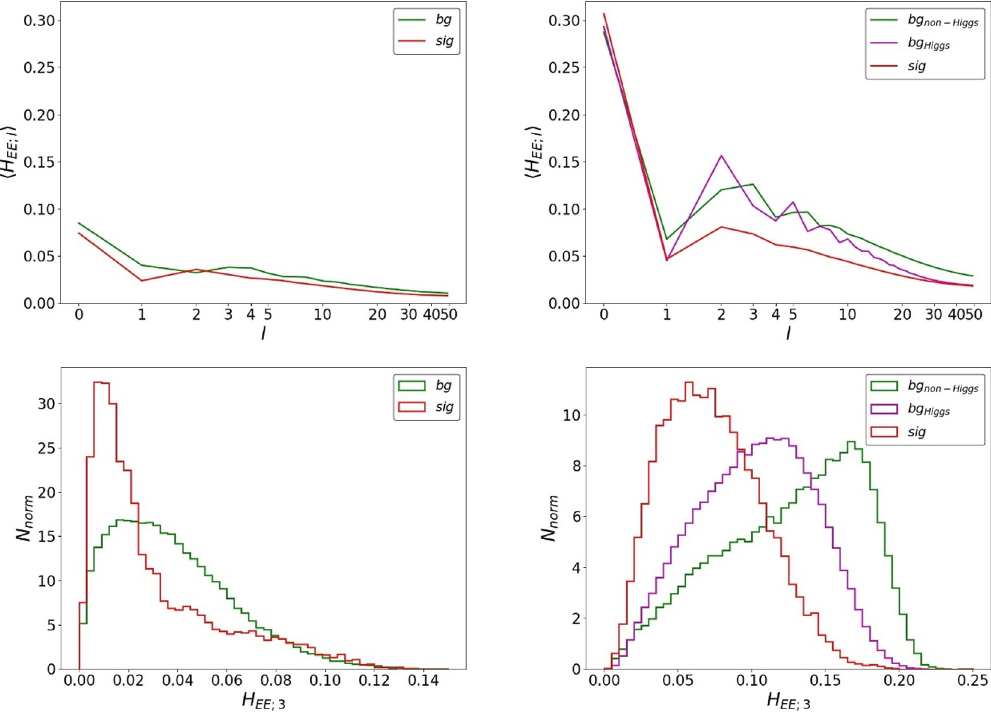
Figure 15 . FW spectra of h H EE ; l i (upper) and event distributions of H EE ;3 (bottom) for the Z (cid:23) h W (left) and Z (cid:23) h W (right) and their respective background samples after preselection. In qq lq the left panels, the contributions from the isolated lepton have been